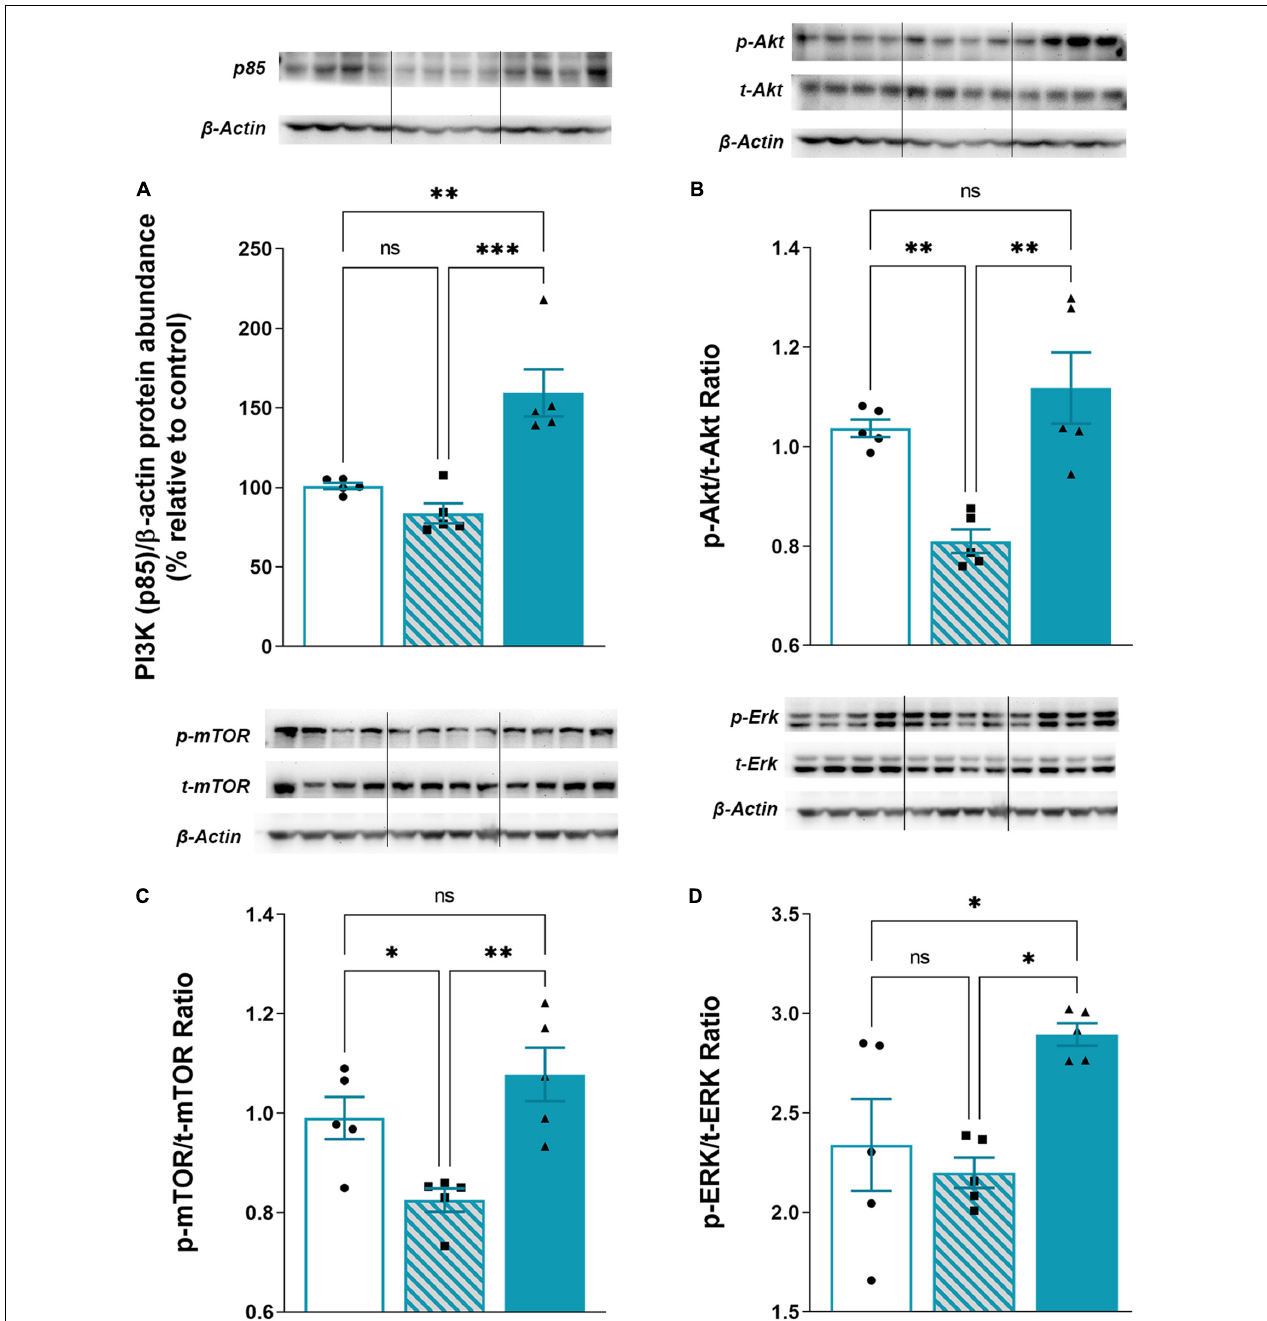
FIGURE 7 | Effect of iTBS treatment on TMT-attenuated PI3K/Akt/mTOR signaling. Representative support membrane and quantitative data of Western blot analysis showing relative protein abundance of (A) PI3K (p85) or phosphorylated/non-phosphorylated (B) p-Akt/t-Akt ratio, (C) p-mTOR/t-mTOR, (D) p-ERK/t-ERK ratio in the hippocampal cytosol. Bars represent mean value of target protein (A) or ratio of phosphorylated and non-phosphorylated forms (B–D) normalized to β -actin abundance ± SEM (from n = 4–5 individual animals, in 2–4 technical replicates), expressed relative to control (arbitrary defined as 100%). Results of post hoc Tukey’s test and significance are shown inside graphs: ∗ p < 0.05, ∗∗ p < 0.01, ∗∗∗ p < 0.001, ∗∗∗∗ p < 0.0001, ns, no significance. Dots in the graphs represent values of individual